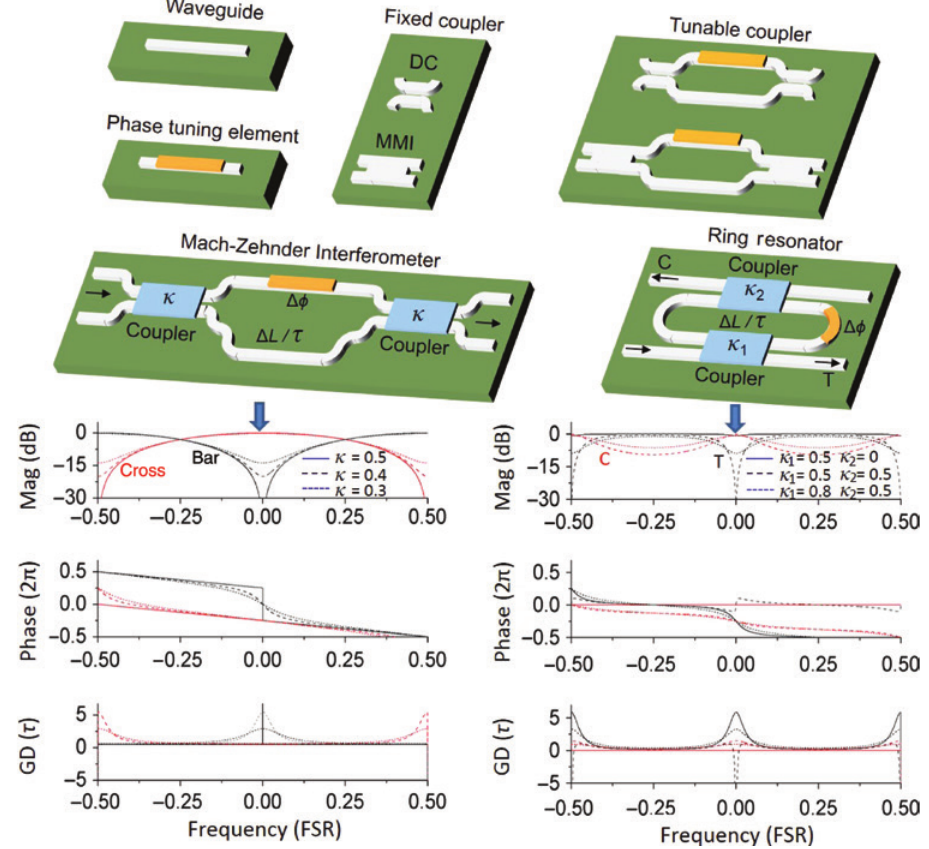
Figure 4: Schematics of basic waveguide building blocks for constructing integrated photonic signal processors and architectures as well as frequency responses examples of a Mach-Zehnder interferometer and a ring resonator (Mag, magnitude; GD, group